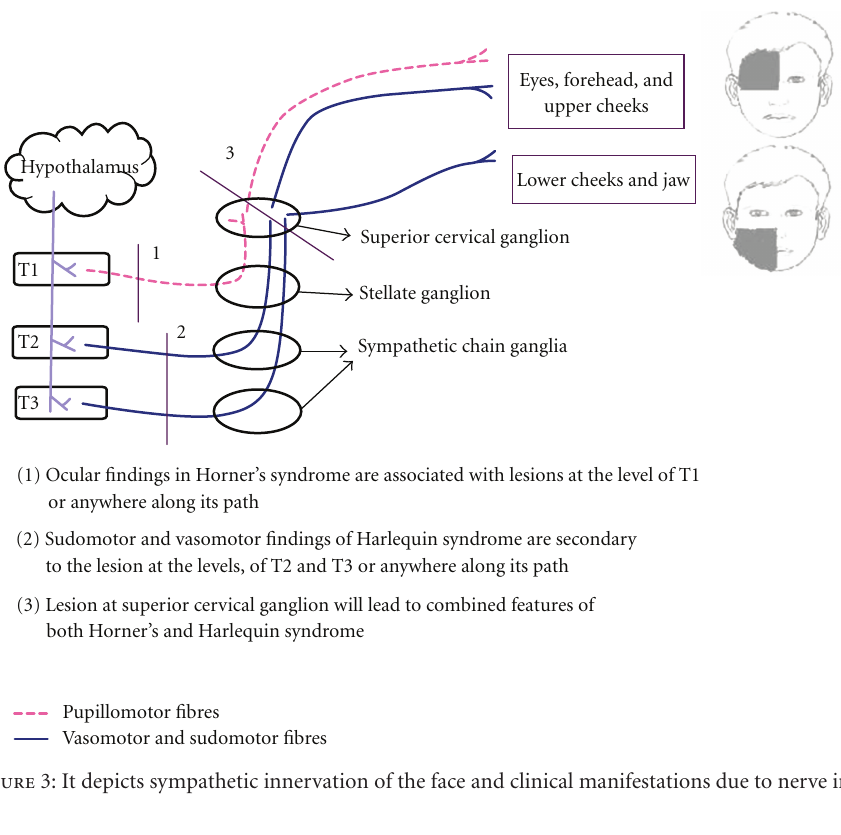
Figure 3: It depicts sympathetic innervation of the face and clinical manifestations due to nerve injury.